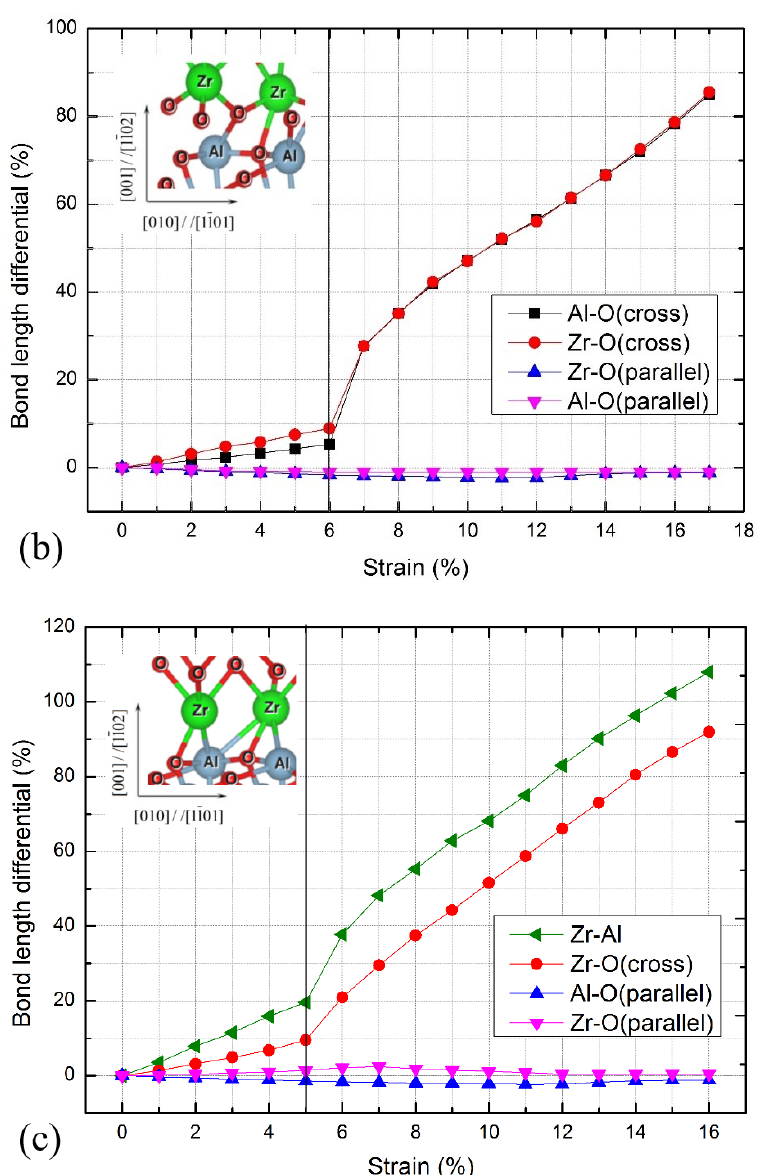
Figure 3. Interfacial bond length differentials for c-ZrO 2 (001)/ α -Al 2 O 3 (1102) interfaces during the stretching process. ( a ) O-terminated, ( b ) 2O-terminated, and ( c ) Zr-terminated. The vertical line indicates the critical strain. Pictorial showing the interfacial bonds is shown in the inset panel. The green, grey, and red spheres represent Zr, Al, and O atoms, respectively.